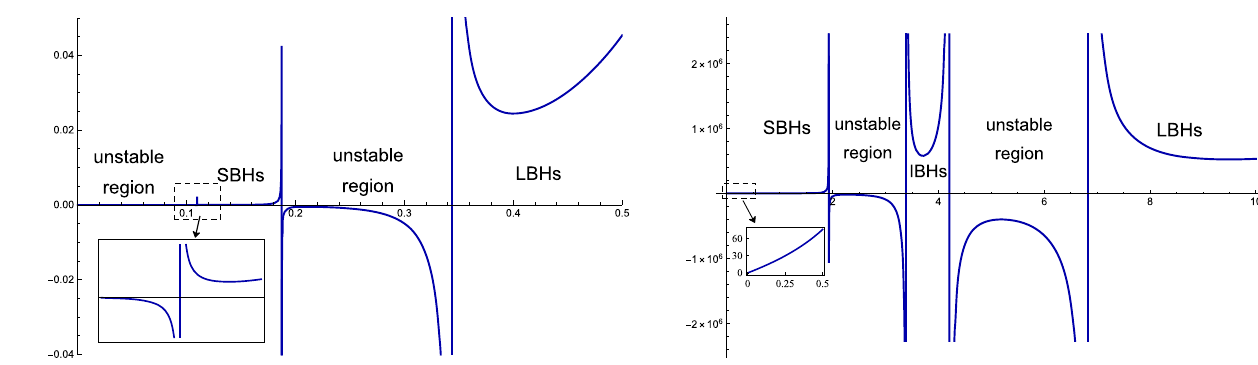
Fig. 11 Three divergence points and RPT: C P , X d = 10, P = 3 . 94, q = 0, m = 0 . 1, c 0 = 1, c 1 = − 9, c 2 = − 2, c 3 = − 1, c 4 = 0 and α = 0 . 01. In order to observe the well-known RPT, the pressure must be chosen near the virtual triple point ( P tr ). See Fig. 11 for the corresponding P − r + , T − r + and G − T phase diagrams